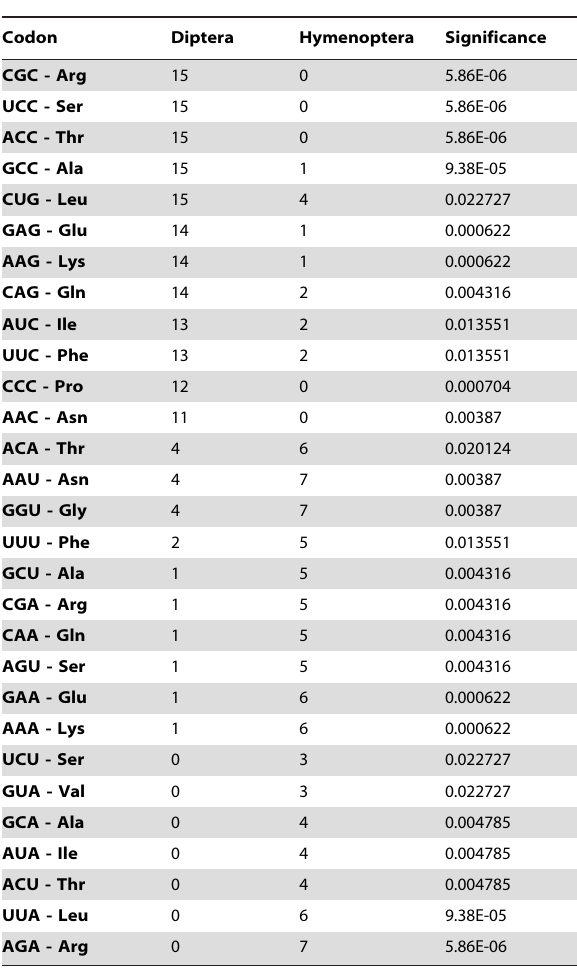
Table 1. Codons that are used more frequently than expected (RSCU . 1) among the dipteran and hymenopteran insects.